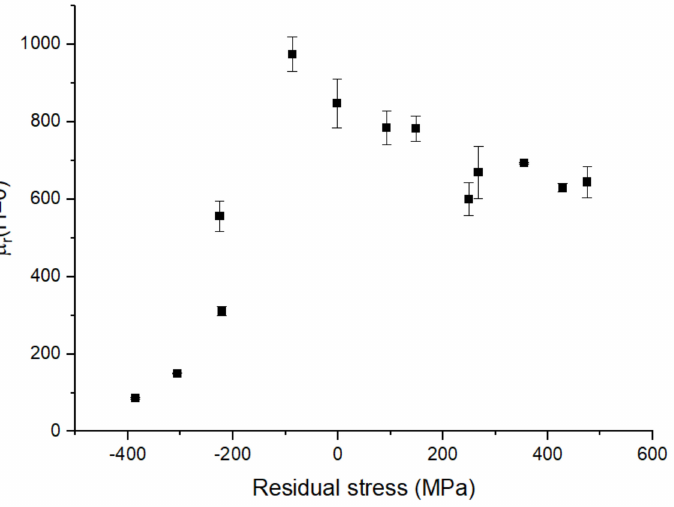
Figure 12. Relative magnetic permeability µ r extracted from the magnetization curves of sputtered FeCuNbSiB as a function of the film